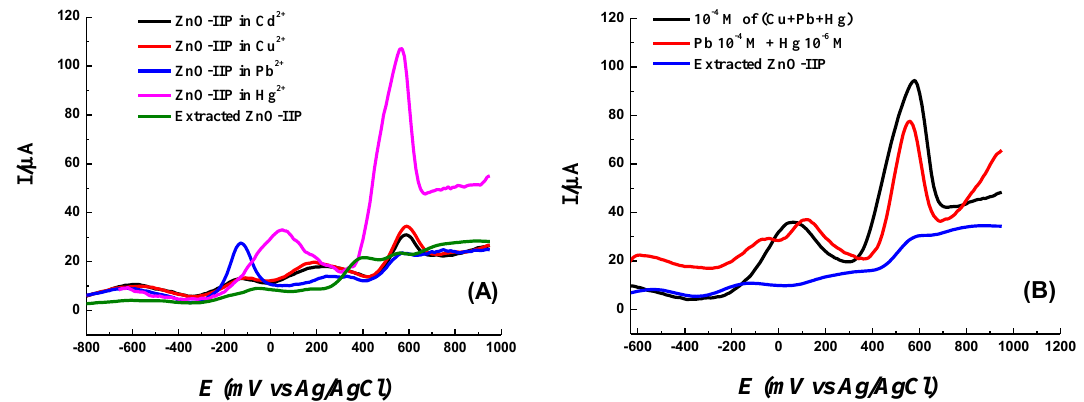
Figure 12. Evaluation of sensor’s selectivity. ( A ): SWV curves in H 2 O/KCl 0.1 M solution of ZnO/Hg(II)-IIP electrodes incubated in 10 −4 M solutions of either mercury, cadmium, lead or copper ions for 20 min. ( B ): Competition tests. Conditions: E-pulse: 0.01 V, E-step: 0.01 V, frequency: 25 Hz, equilibration time: 2 s.